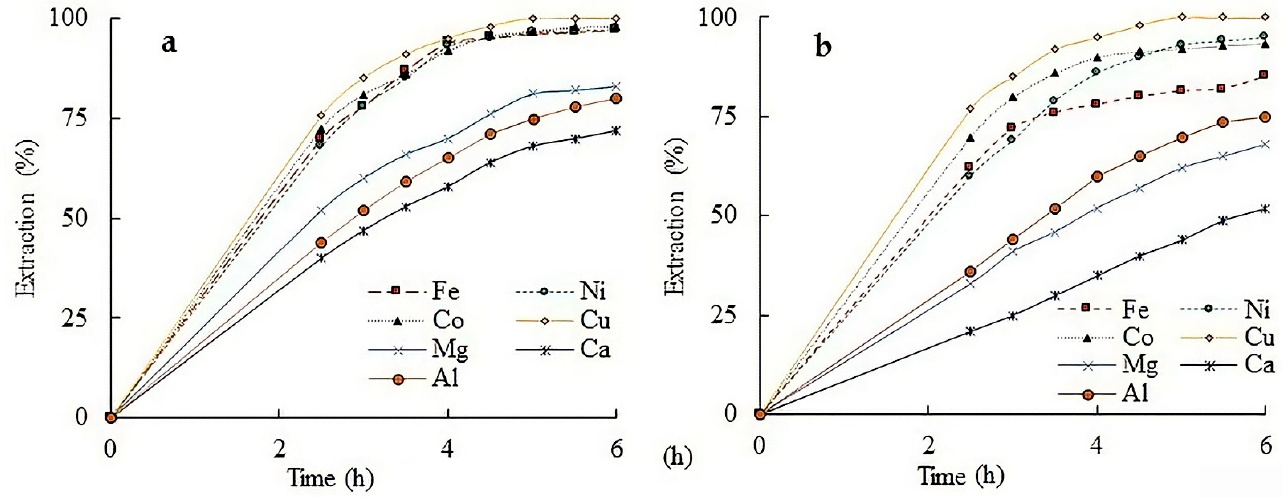
Figure 5. The extraction percentages of target components from converter slag (Sample 774 and Sample 813) as a function of leaching time ( a − Sample 774; b – Sample 813). Conditions: t = 80 °C,